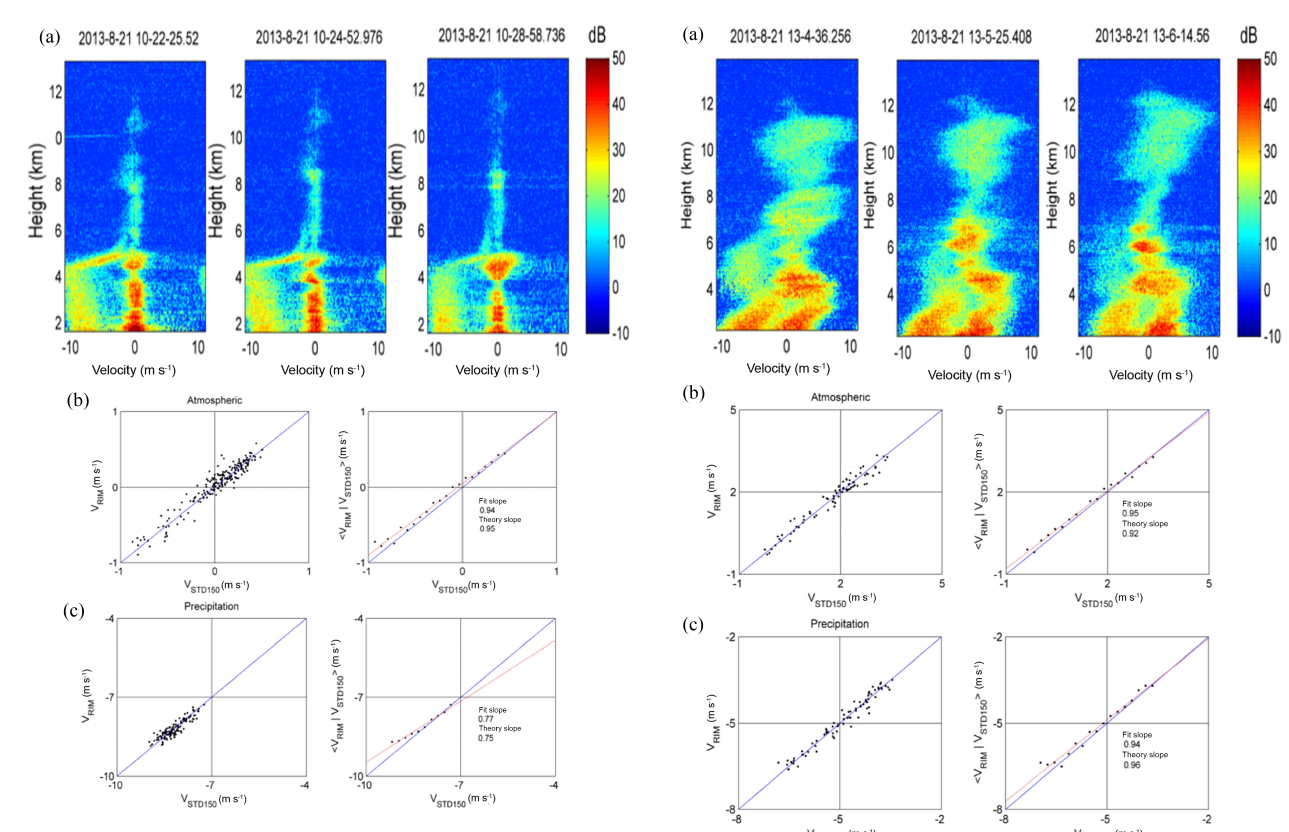
Figure 7. (a) Capon RIM-processed power spectra during strat- iform precipitation. Data time and date: 10:22:25–10:28:58UT, 21 August 2013. Panels (b, c) are similar to those in Fig. 6a and b, but for Doppler velocity (red line is the fit slope).